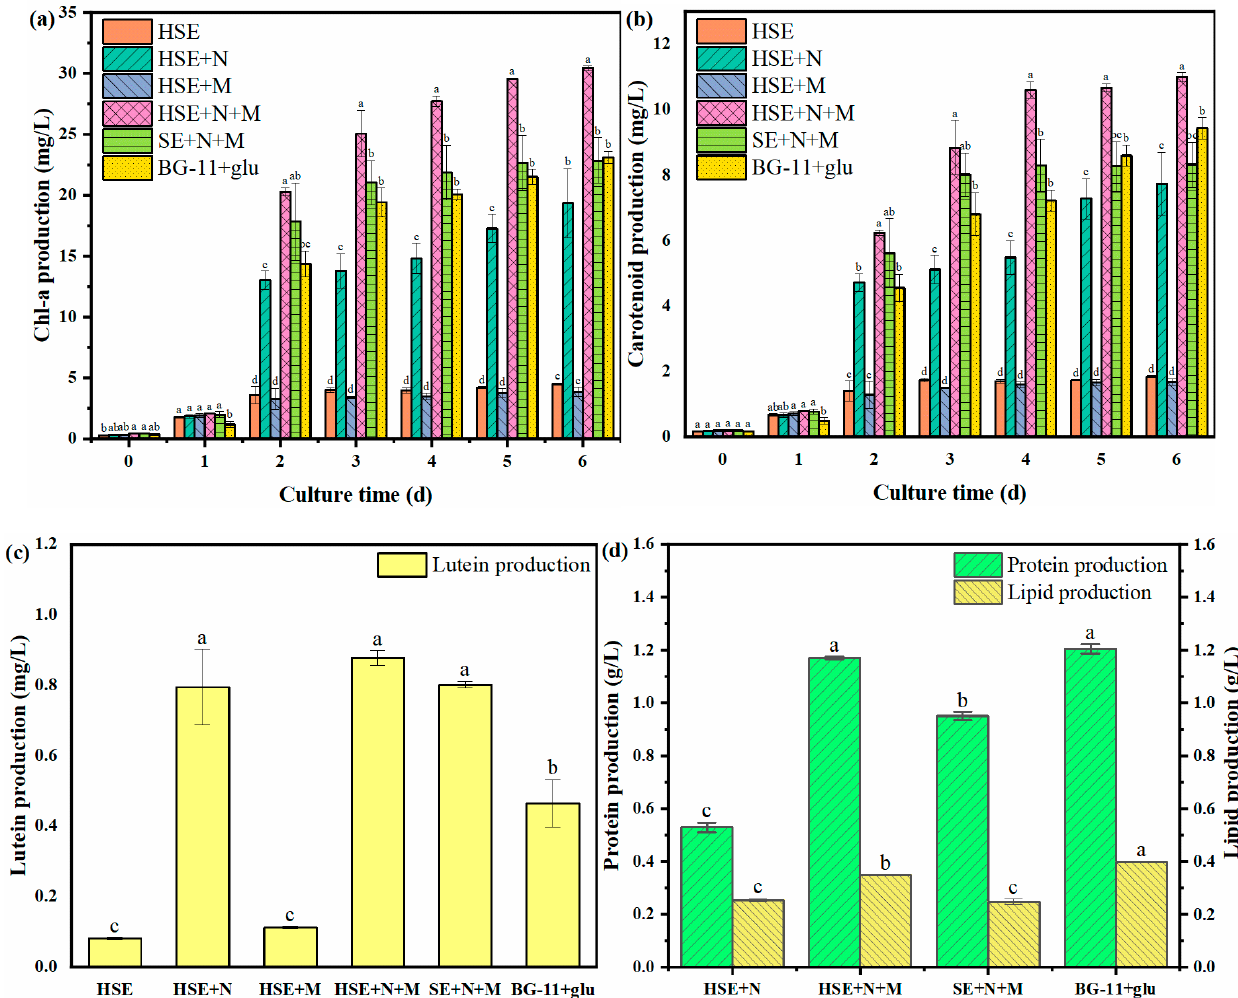
(Table 4). The nitrogen consumption of C. vulgaris in the HSE+N+M and SE+N+M groups was comparable to that of the BG-11+glu group, while those two groups had lower biomass source by C. vulgaris was improved in the SE and HSE. The lipid content of the HSE+N+M group was 0.16 g/g, which was 1.2 times that of the BG-11+glu group (Table 4). However,